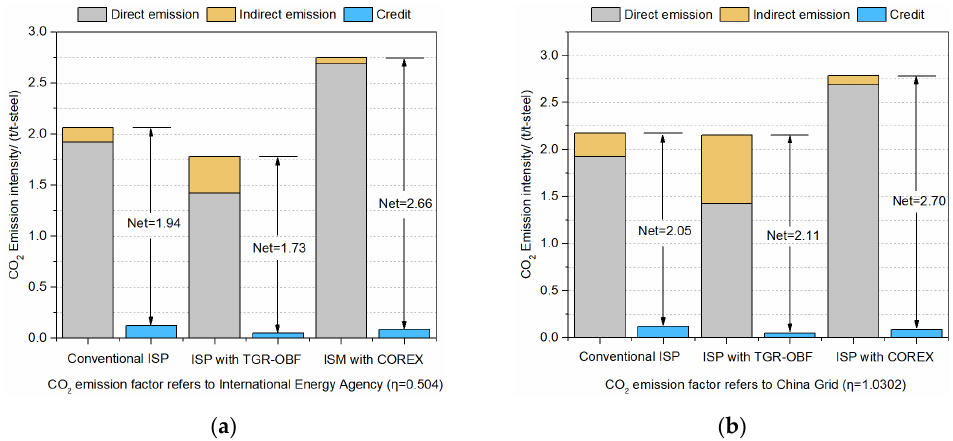
Figure 10. The CO 2 emissions intensity in the conventional ISP, the ISP with the TGR-OBF, and the ISP with the COREX with the CO 2 emissions factor referring to the world average ( a ) or North China Grid ( b ).